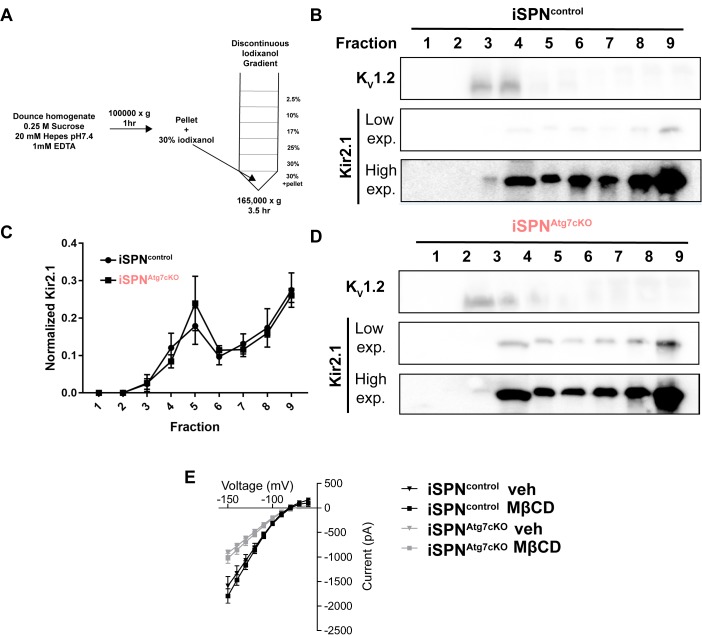
Plasma membrane floatation and MBCD treatment.(A) Schematic of iodixanol gradient. (B,D) representative blots of gradient fractions. (C) Aggregate data of Kir2.1 in each fraction normalized to the total amount of Kir2.1 across the gradient. No difference in Kv1.2 levels or distribution and no difference in Kir2.1 distribution was seen. N = 3 mice per genotype. Data analyzed by repeated measure, two-way ANOVA. Genotype x fraction: F(8,48) = 0.3456, p = 0.9433; Genotype: F(1,6)=2.455, p = 0.1682; Fraction: F(8,48) = 16.28, p<0.0001. (E) Kir2 currents from iSPNs from slices pretreated with methyl-β-cyclodextrin (MBCD; 10 mM) were recorded. No effect of MBCD was seen at either genotype. iSPNCtrl: Veh N = 8, MBCD N = 6. iSPNAtg7cKO: Veh N = 5, MBCD N = 7 (Cells from two mice per condition).